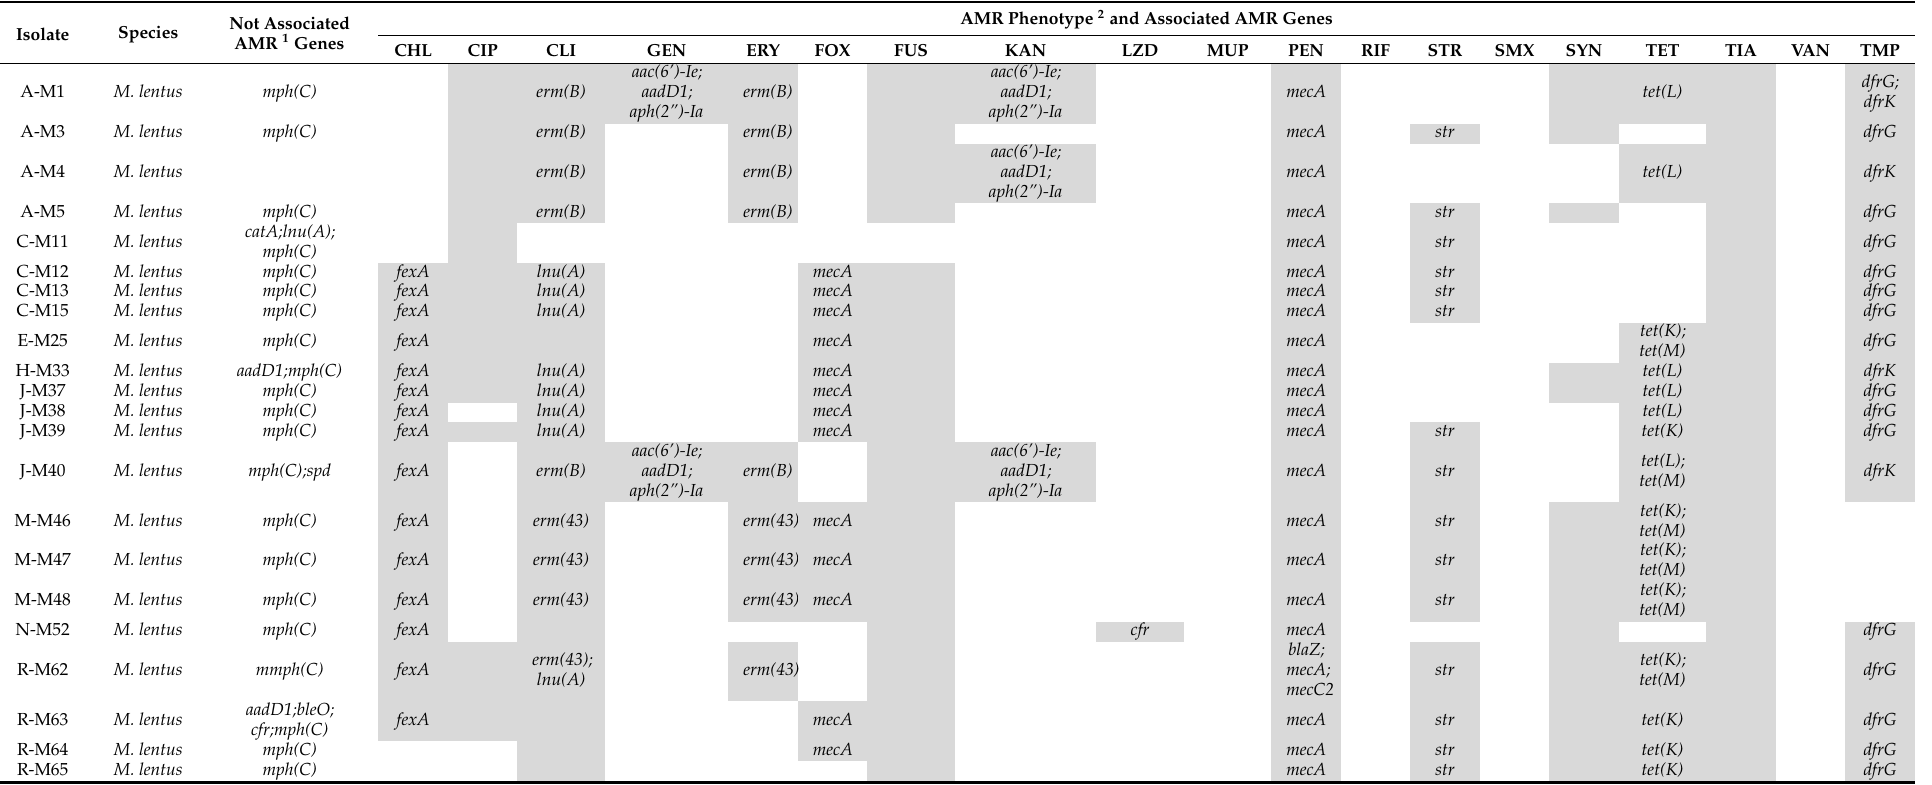
Table 2. Predicted antimicrobial resistance genes compared to phenotype according to minimum inhibitory concentrations of various antimicrobial substances for the M. lentus isolates. Non-wildtype phenotypes were evaluated according to EUCAST ECOFFs. Grey background represents resistance to respective antimicrobial